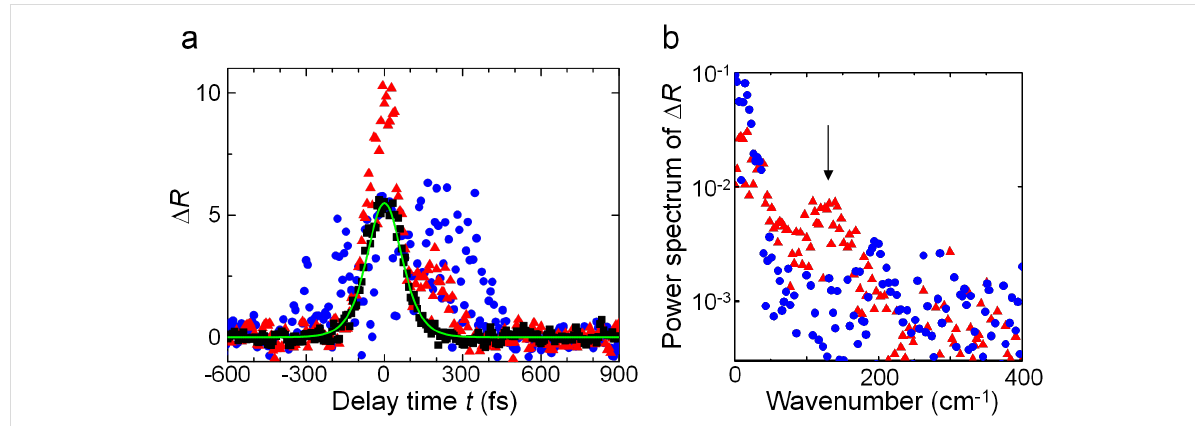
Figure 4: a) Instantaneous relative increase in reflected light intensity, Δ R , measured by pump–probe method. Black squares, blue circles, and red triangles indicate measurement results for samples C, D, and E, respectively. The solid green line indicates the approximation curve Δ R fit = 5.5 sech 2 ( t /(9 × 10 − 14 )) for Δ R C . b) Power spectrum obtained by subtracting the Δ R fit component from Δ R D , and Δ R E . The blue circles and red triangles indicate the analysis results for Δ R D , and Δ R E , respectively. The arrow indicates 128 cm − 1 .